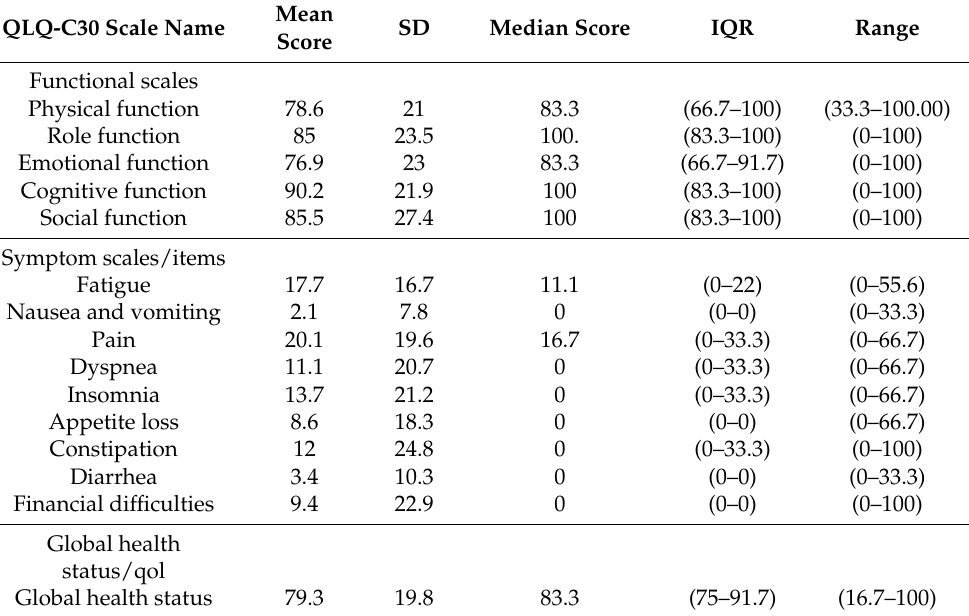
Table 2. Total scores for QLQ-C30 questionnaire (Version